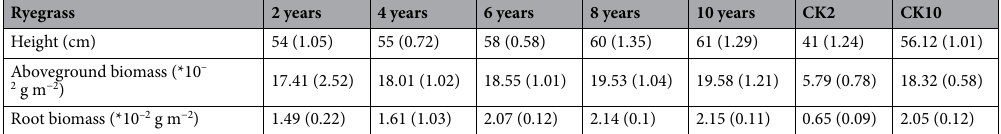
Table 1. Height and biomass of ryegrass in reconstructed mine substrates (RMS). Parentheses show standard deviations.